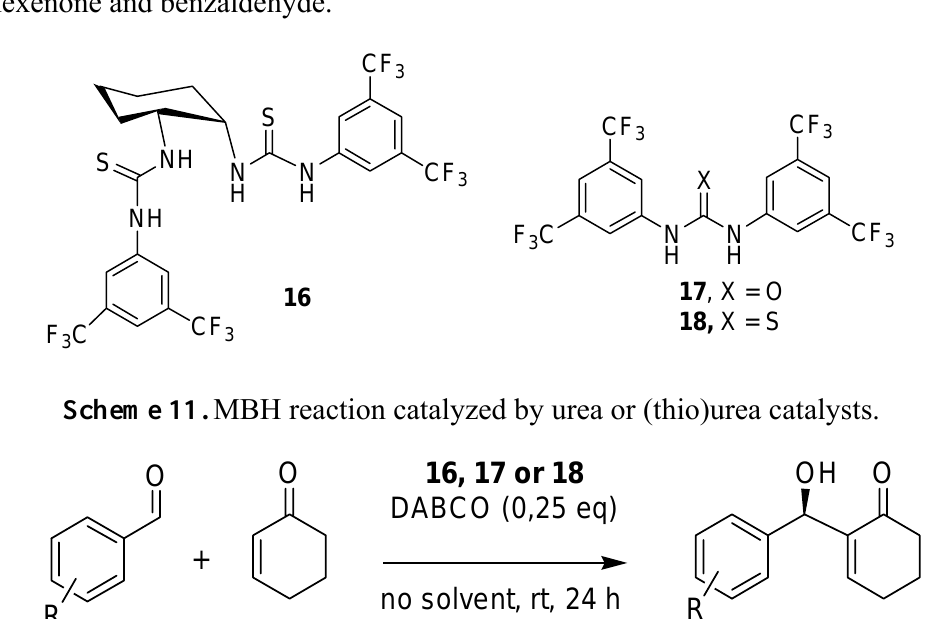
Figure 4. Urea and (thio)urea type organocatalysts used for MBH reaction between cyclohexenone and